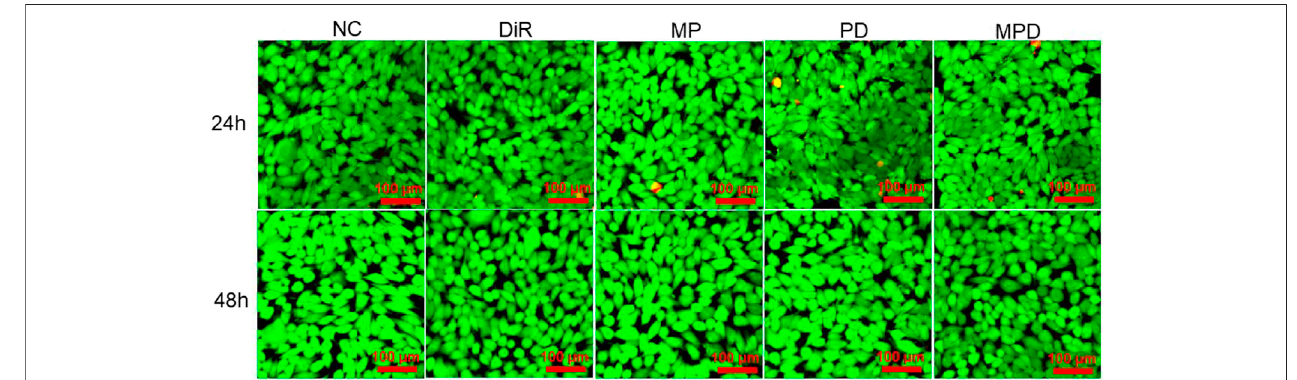
FIGURE 2 | Cytotoxic assay of LLC cells treated with MPD and different control formulations.